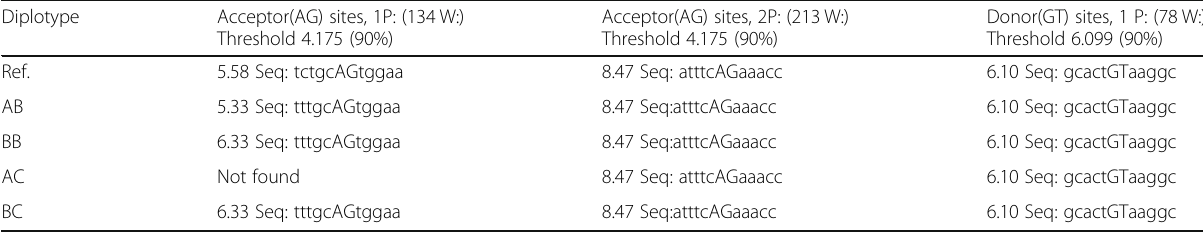
Acceptor(AG) sites the type of splicing sites, P: position of splicing site, W: weight of site. Threshold 4.175 (90%) means that for the current threshold value (4.175) 90% of true splicing sites are being classified as